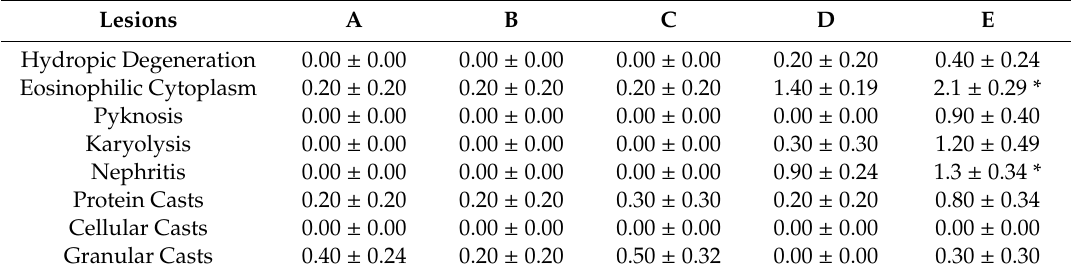
Table 11. Kidney lesion scores (mean ± SEM) for female ICR mice in subacute toxicity study of CELE.